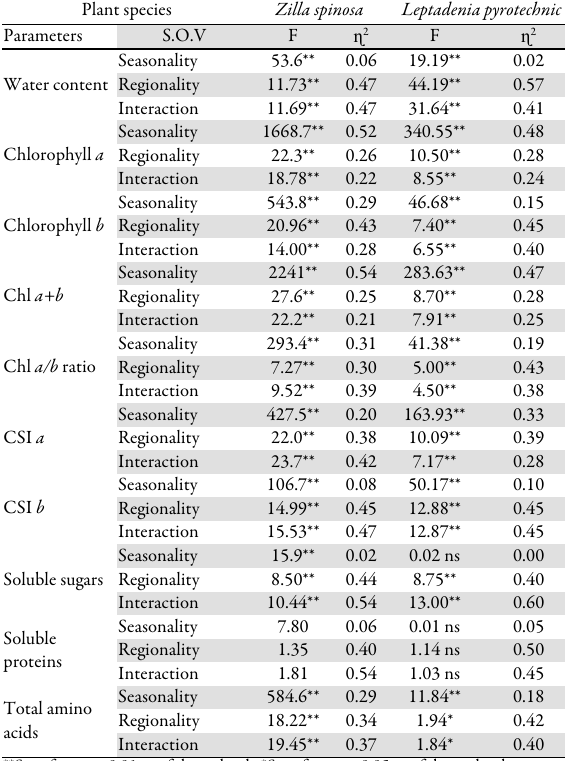
Table 2. Statistical analysis for water content, chlorophyll and organic components of Zilla spinosa and Leptadenia pyrotechnic showing analysis of variance (F-value) and determination coefficient ( ɳ 2